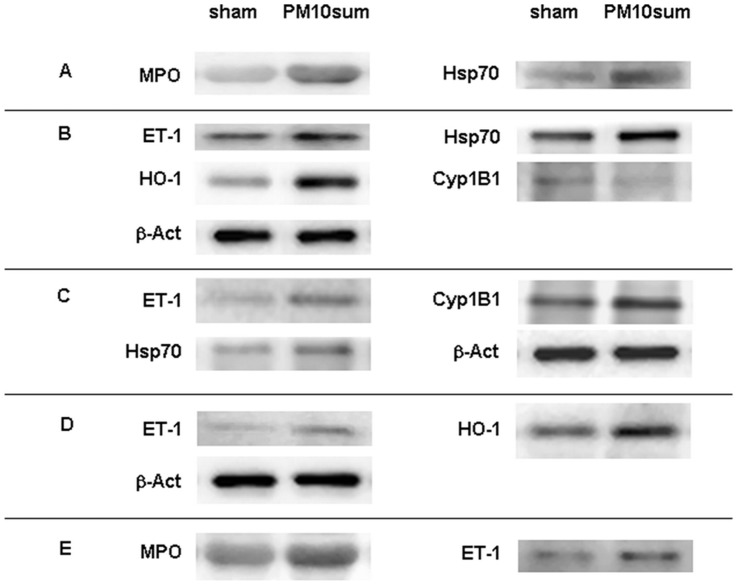
BALf, lung, heart, brain and plasma immunoblotings.Western blottings displaying proteins in BALf (A), lung (B), heart (C), brain (D) and plasma (E) in sham and PM10sum-treated mice, 24 h after the third intratracheal instillation. Reported blots are representative of 6 sham and 6 PM10sum-treated mice; densitometry analyses are reported in Tab.1.